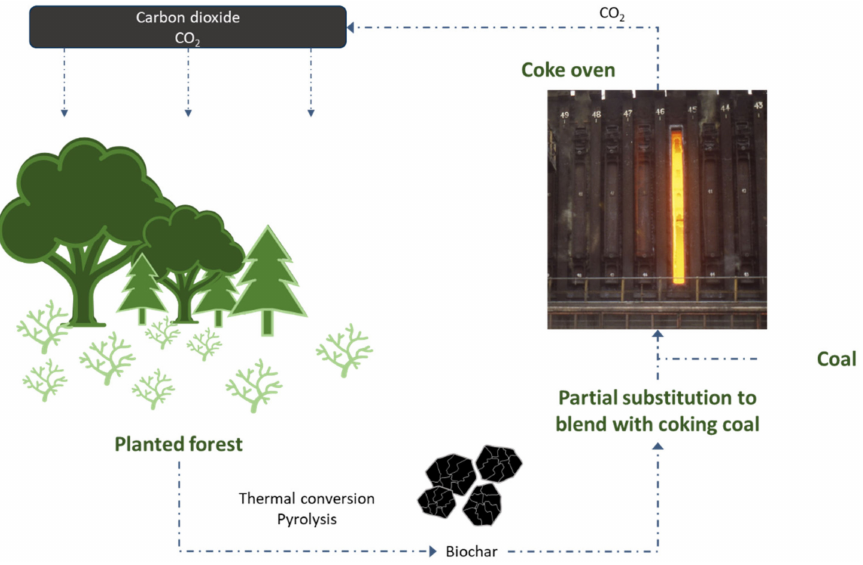
Figure 3. Utilization of biochar in